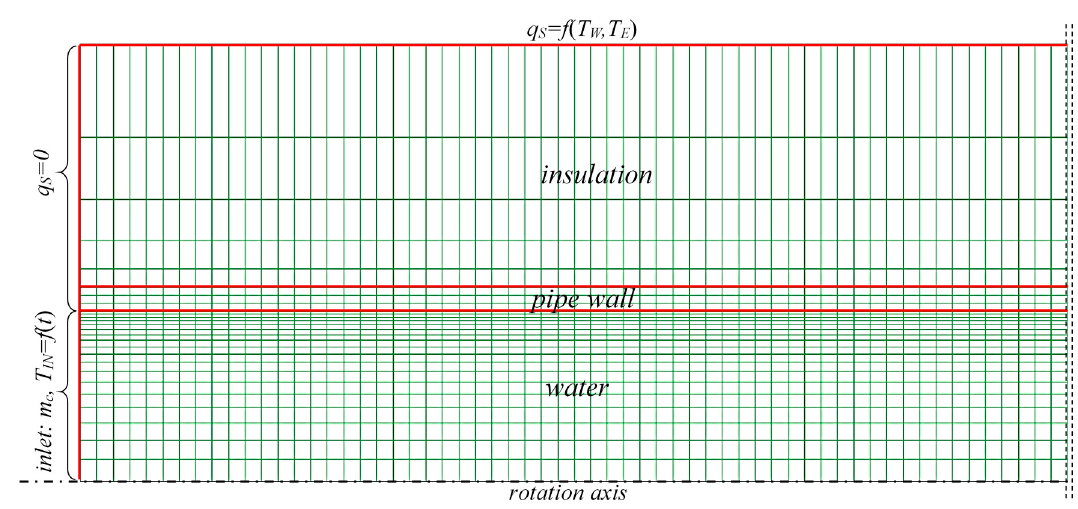
Figure 11. Fragment of the mesh with boundary conditions.